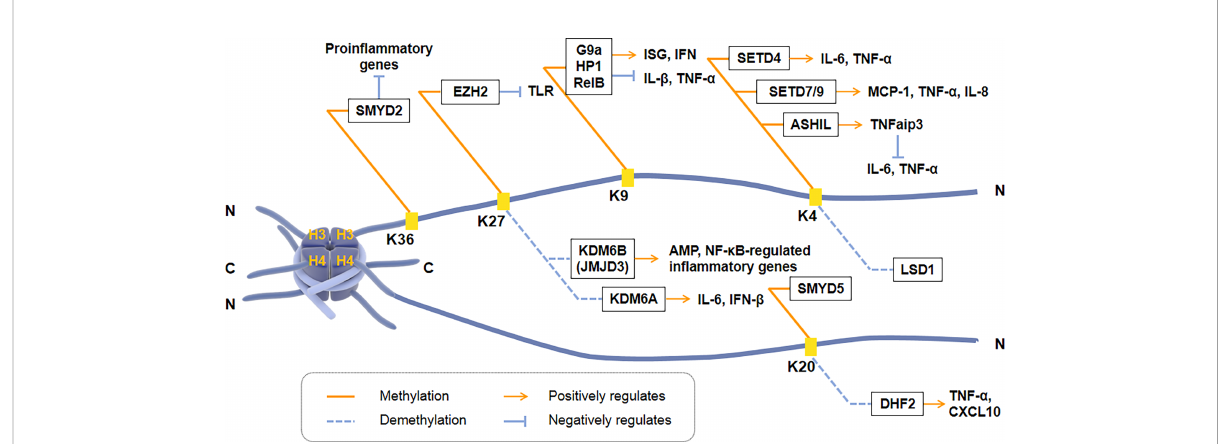
FIGURE 2 Regulation of transcriptional activation of in fl ammatory cytokines by histone methyltransferases and demethylases. Histone methylation occurs at the N-terminus of Lysine or Arginine residues of Histone H3 and H4, including H3K4, H3K9, H3K27, H3K36, and H4K20. SMYD2, EZH2, G9a, SETD4, SET7/9, ASH1L and SMYD5 are histone methyltransferases. KDM6B (JMJD3), KDM6A, LSD1 and DHF2 are histone demethylases. ISG, IFN-stimulated gene; TNFaip3, a negative regulator of TLR signaling